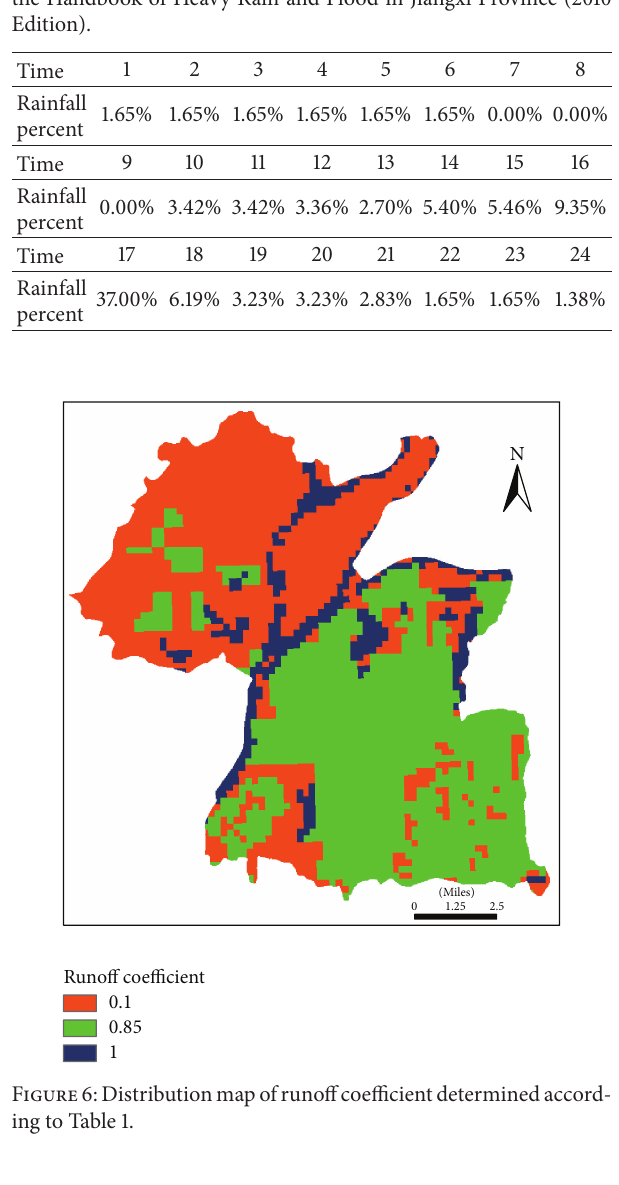
Figure 5: Remote sensing image coming from 2.5-meter resolution SPOT satellite photograph data.